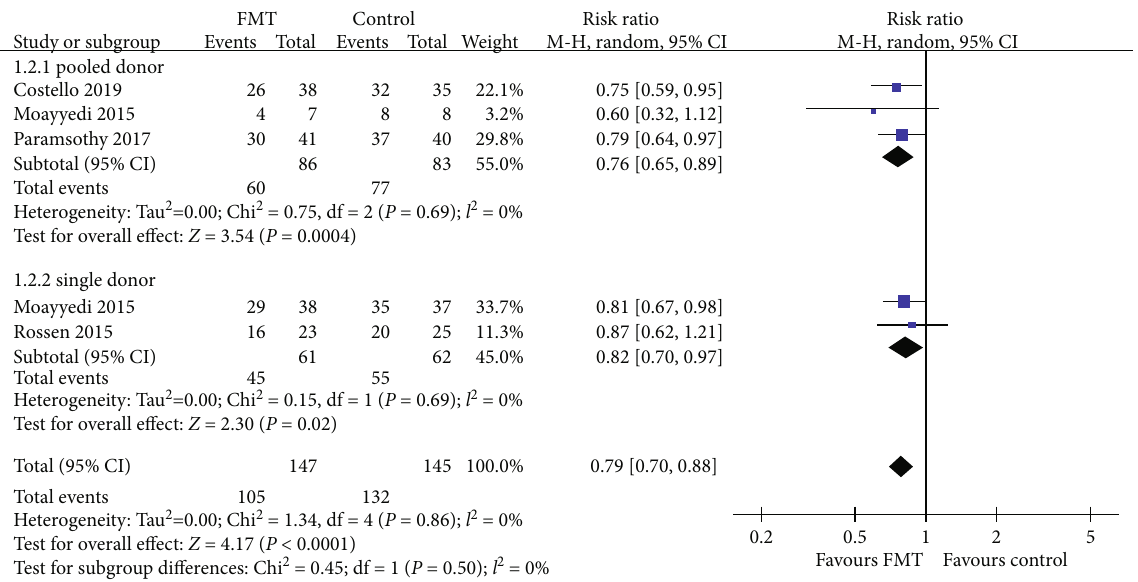
Figure 4: Forest plot of studies reporting combined clinical remission with endoscopic remission/response and subgroup analysis according to number of